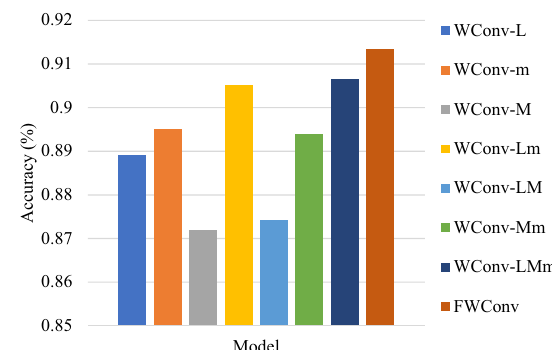
Figure 15 Diagnostic results of CNN with different first